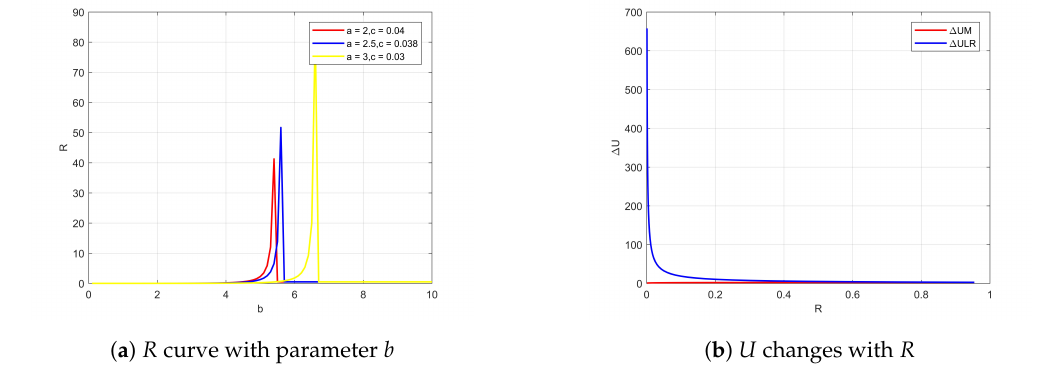
Figure 6. R curve with parameter b and U changes with R